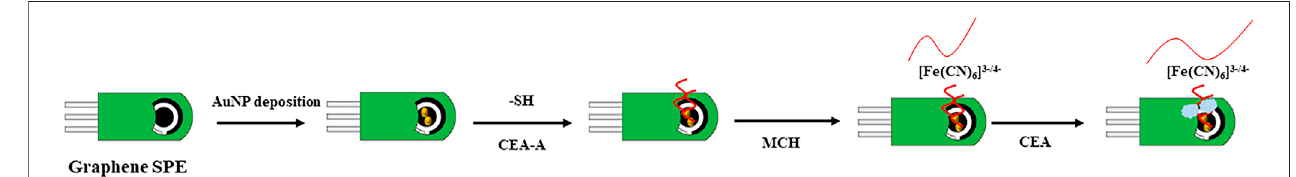
FIGURE 1 | Preparation process of the aptamer sensor and the principle of detecting